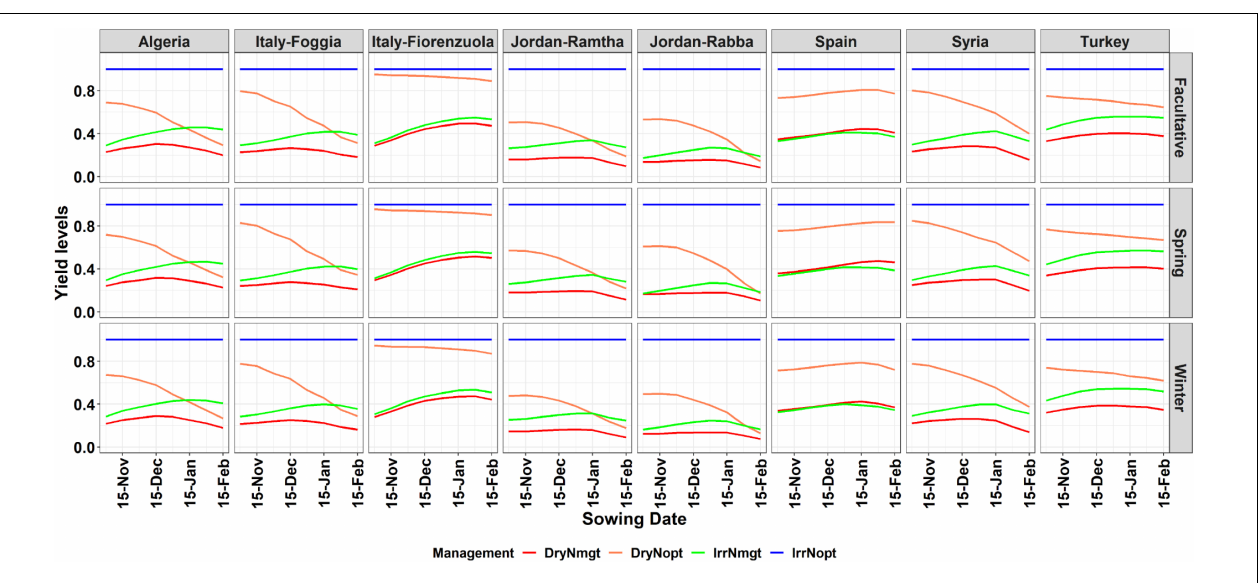
FIGURE 4 | Yield gap between the different barley types simulated with optimal managements conditions (no water or nitrogen stresses; IrrNopt , blue top straight line), no water stress and current nitrogen management ( IrrNmgt , green line), dryland and optimal nitrogen management ( DryNopt , orange line), and under current management conditions ( DryNmgt , red